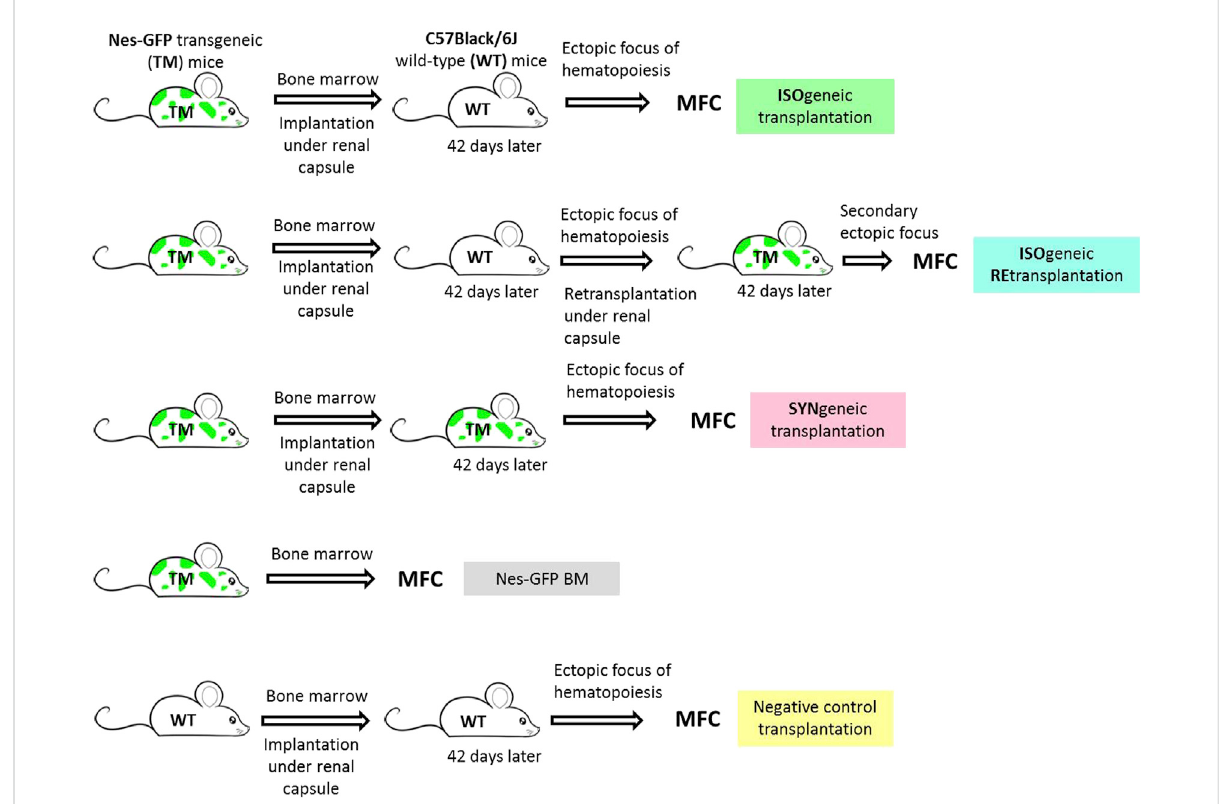
FIGURE 2 Experimental groups. Isogenic transplantation group corresponds to C57Black/6J wild-type immunocompetent recipients of Nes-GFP bone marrow under the renal capsule. Isogenic retransplantation group corresponds to Nes-GFP recipients of primary foci formed in isogneic transplantations. Syngenic transplantation group corresponds to Nes-GFP recipients of Nes-GFP bone marrow under the renal capsule. Nes-GFP BM group is primary bone marrow of Nes-GFP mice. Negative control transplantation corresponds to C57Black/6J wild-type immunocompetent recipients of syngenic bone marrow under the renal